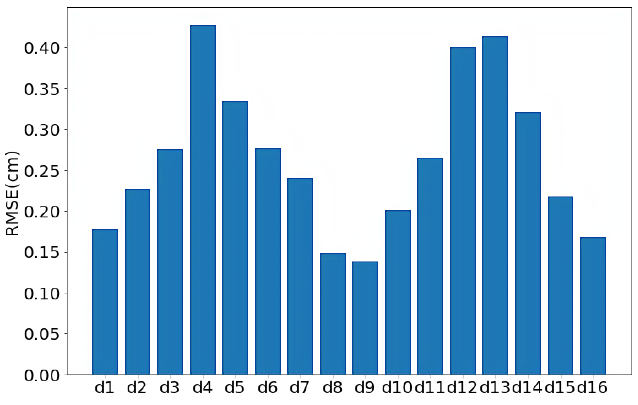
Figure 4. RMSE of predicted distance on test data.